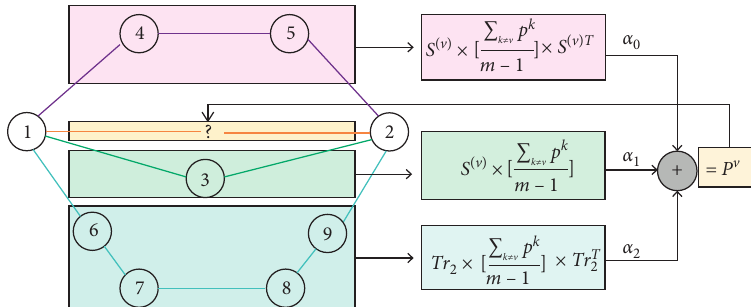
Figure 7: A toy example illustration. Green part is an iterative process that directly uses adjacent information. Purple part is an iterative process that uses first-order neighbor similarity information. Blue part is an iterative process that uses second-order neighbor similarity information. The final summation is the approximate similarity between nodes 1 and 2.